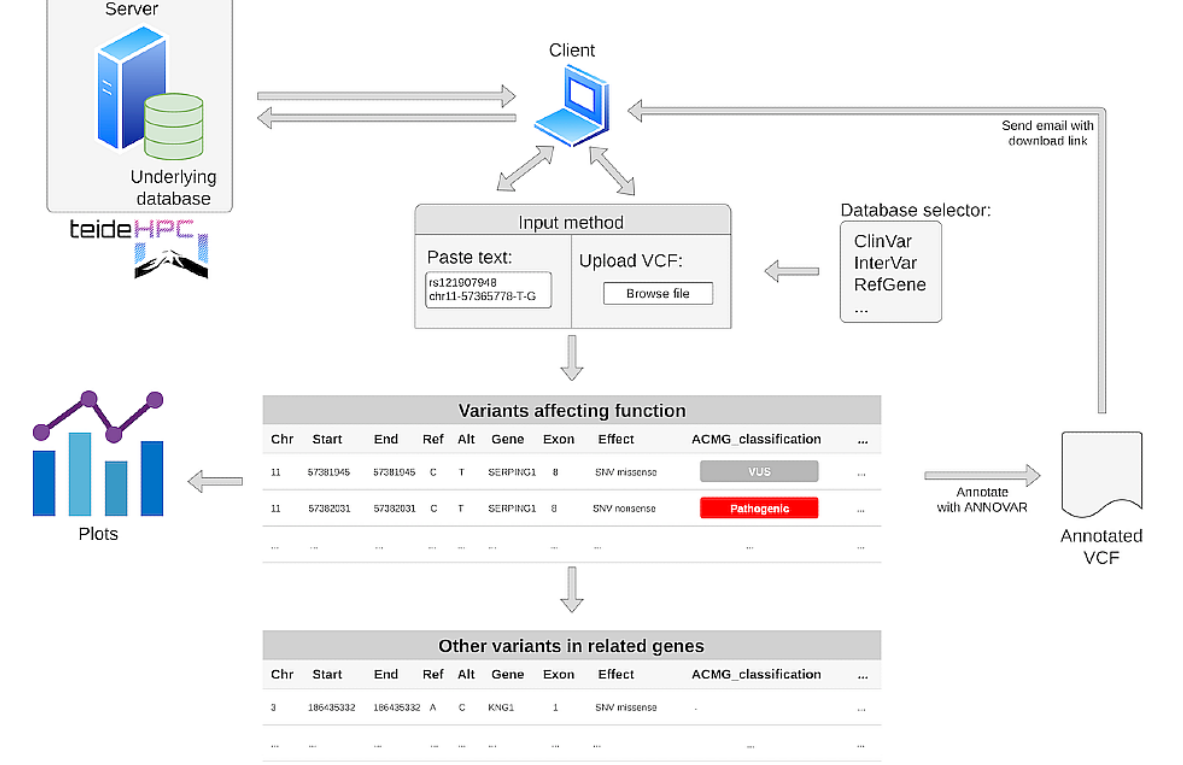
Figure 2. Schematic representation of the HADA architecture and user interface. HADA is hosted on a server at TeideHPC, through a UI-based on Shiny. When the user sends a query to the server, it is encrypted and interrogates the HADA database, and returns matched variants affecting function associated with hereditary angioedema. The app also searches the data for other variants located within known hereditary angioedema genes to facilitate the identification of potentially novel variants. Once finished, an email with the link to download the annotated variant calling file (VCF) is sent to the user. At the end of the process, uploaded and annotated files are deleted from the